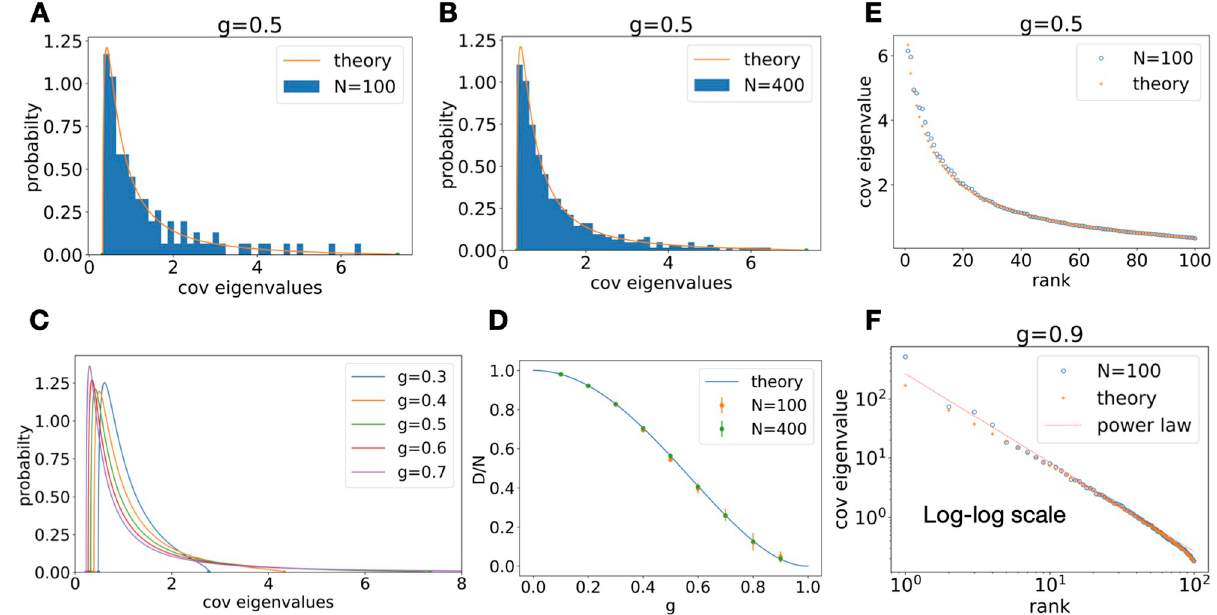
Fig 1. Covariance spectrum under random Gaussian connectivity. A . Compare theory (Eq (5)) with finite-size network covariance using Eq (2) at N = 100, g = 0.5. The histogram of eigenvalues is a single realization of the random connectivity. B . Same as A. at N = 400. C . Covariance eigenvalue distribution at various value of g . As g increases the distribution develops a long tail of large eigenvalues. D . Dimension (normalized by network size) vs g . The dots and error bars are mean and sd over repeated trials from finite-size networks (Eq (2) and use Eq (4)). Note some error bars are smaller than the dots E . Covariance eigenvalues vs. their rank (in descending order). The circles are covariance eigenvalues from a single realization of the random connectivity with N = 100 (Eq (2)). The crosses are predictions based on the theoretical pdf (Eq (5)). F. Same as E. but for g = 0.9 and on the log-log scale. The red dashed line is the power law with exponent − 3/2 derived from Eq (5), see Section 3.2.